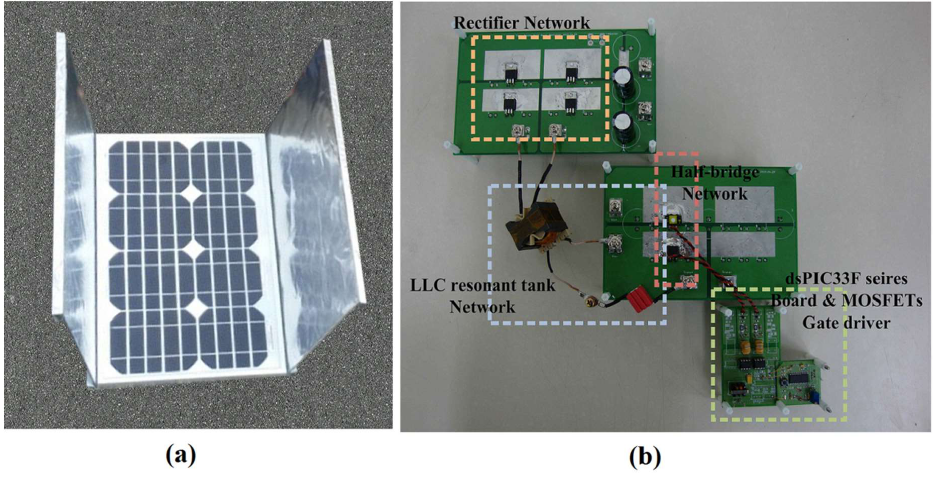
Figure 10. Experimental arrangements for ( a ) Al-foil based BRS; ( b ) Hardware implementation of 400 W Half bridge LLC converter prototype.